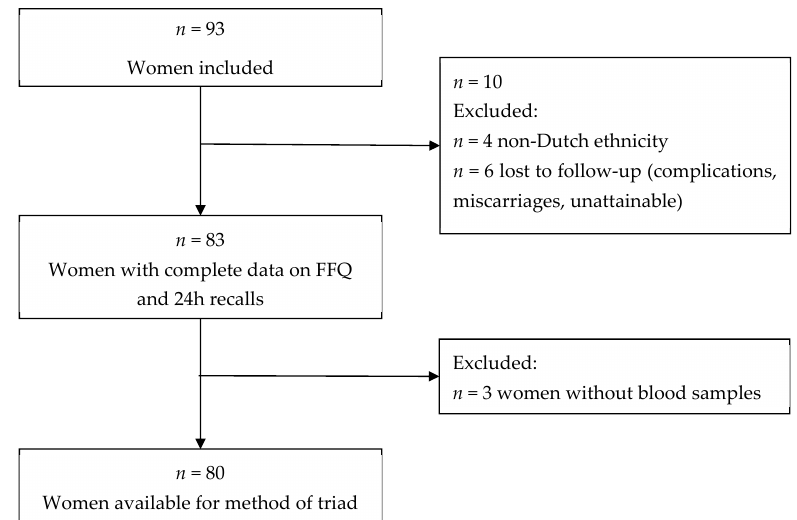
Figure 1. Figure 1. Flow-chart.